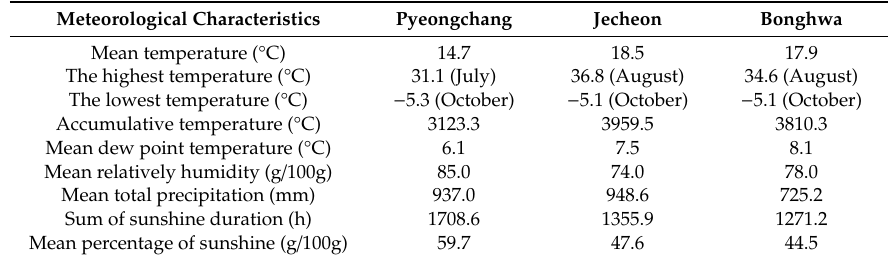
Table 10. Meteorological characteristics of Angelica gigas Nakai cultivation sites (data measured in Korea Meteorological Administration from April to October